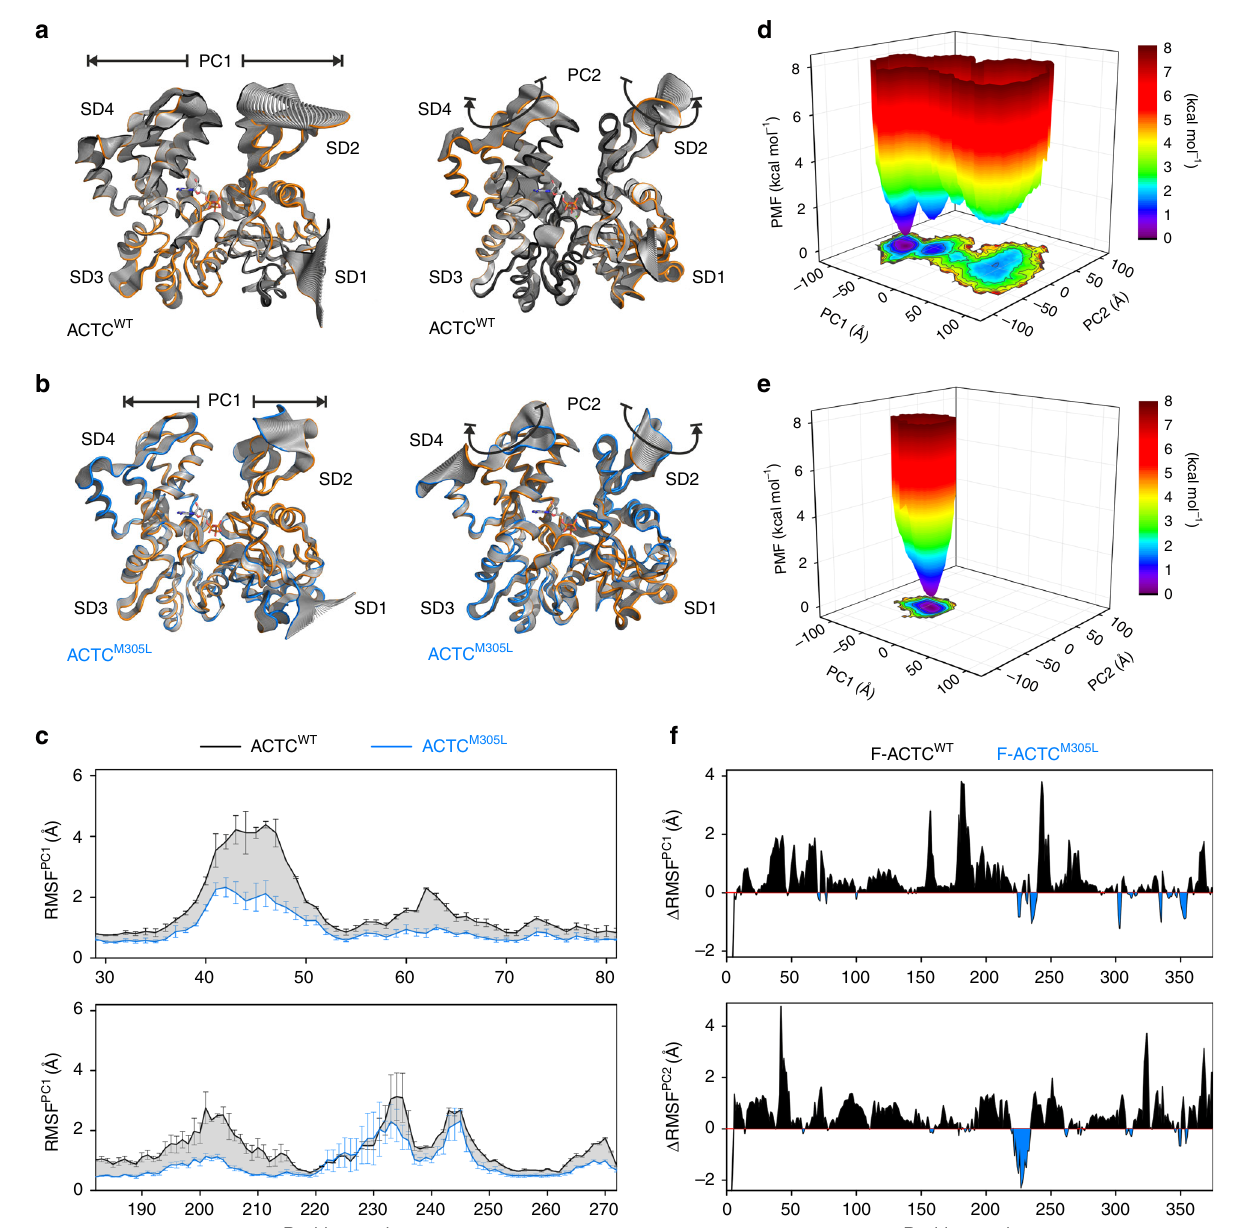
Fig. 5 The M305L mutation decreases actin fl exibility in MD simulations. a Projections of the largest structural fl uctuations according to the fi rst principal component (PC) (left panel) and the second PC (right panel) of a representative cMD simulation of an ACTC WT monomer. The projections indicate major positional deviations of SD2 and SD4, which follow hinge domain (PC1) as well as rotational movements (PC2). b Projections of PC1 and PC2 of a representative ACTC M305L monomer cMD simulation illustrate decreased protein motions compared to wildtype. c Root mean square fl uctuations along PC1 of SD2 (upper panel) and SD4 (lower panel) calculated from monomer cMD simulations. Both SD2 and SD4 show markedly higher fl uctuations in ACTC WT vs. ACTC M305L . Data are represented as mean ± SEM ( n = 3). d The free energy landscape of ACTC WT , calculated as the potential of mean force (PMF) according to the largest structural motions in the protein, as derived from PCA of two combined 500 ns enhanced sampling MD simulations. The color bar represents the PMF value in kcal mol − 1 . e The free energy landscape of ACTC M305L shows a much narrower energy basin as compared to ACTC WT , indicating a highly populated state with reduced fl exibility. Data were obtained from two combined 500 ns enhanced sampling MD simulations. The color bar represents the PMF value in kcal mol − 1 . f Root mean square fl uctuations obtained from F-actin cMD simulations, given as the difference of ACTC WT − ACTC M305L , along PC1 (upper panel) and PC2 (lower panel) con fi rm that the major protomer structural fl uctuations persist in the fi lamentous actin form, and they are decreased in mutant actin. Source data are provided as a Source Data fi